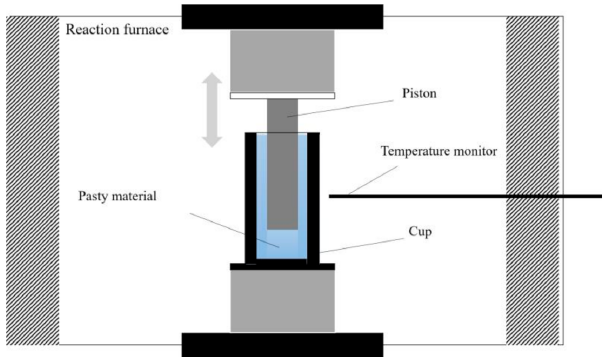
Figure 3. The schematic presentation of the dynamic mechanical